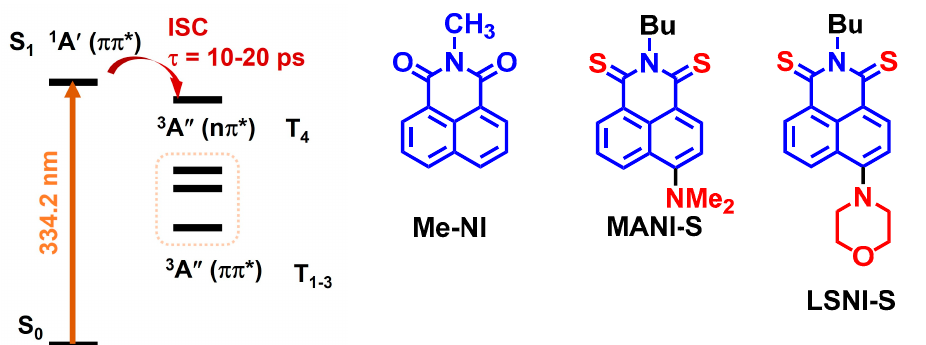
Figure 21. Molecular structure of N -methyl-1,8-naphthalimide (Me-NI) and the ISC mechanism. The derivatives of Me-NI show efficient PDT application (MANI-S and LSNI-S). Reproduced with permission from reference [100], copyright 2016, American Chemical Society.